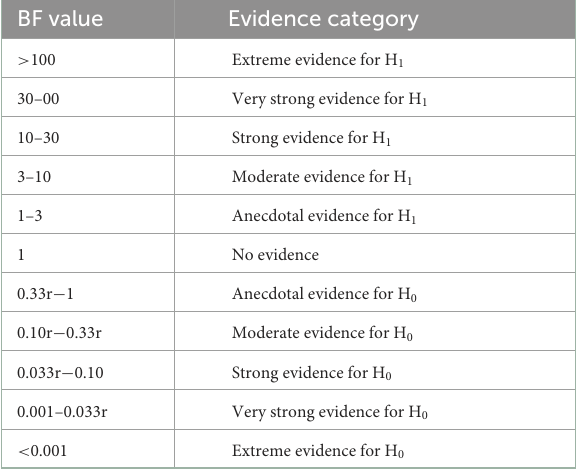
TABLE 1 Interpretation of Bayes factor (BF)